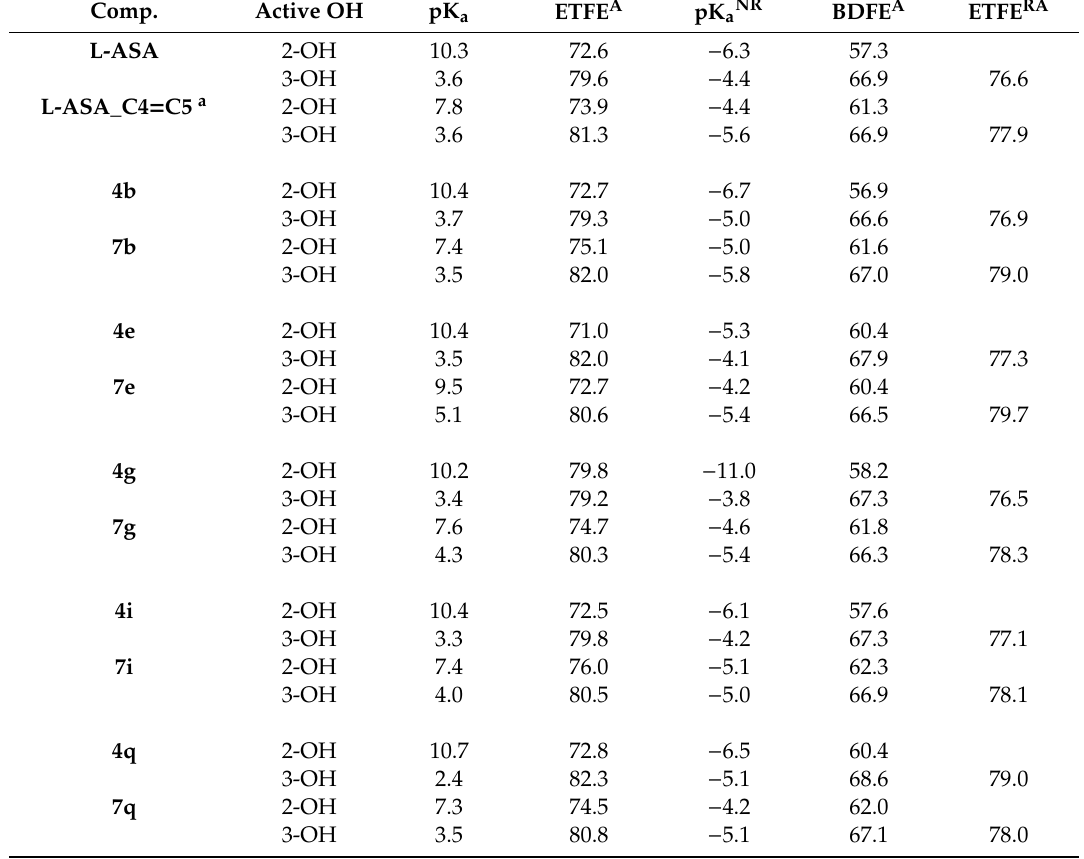
Table 2. Calculated aqueous reaction free energy parameters (kcal / mol): acid dissociation constant of neutral specie (pK a ) and its neutral radical (pK aNR ), electron transfer free energies, and bond dissociation free energy for an anion (ETFE A and BDFE A ), and the ETFE of an intermediate radical anion (ETFE RA ) (Figure 2) for C2-OH and C3-OH groups of selected compound pairs (saturated C4-C5(OH) analogues from series 4 and unsaturated C4 = C5 analogues from series 7 ). Comp. Active OH pK